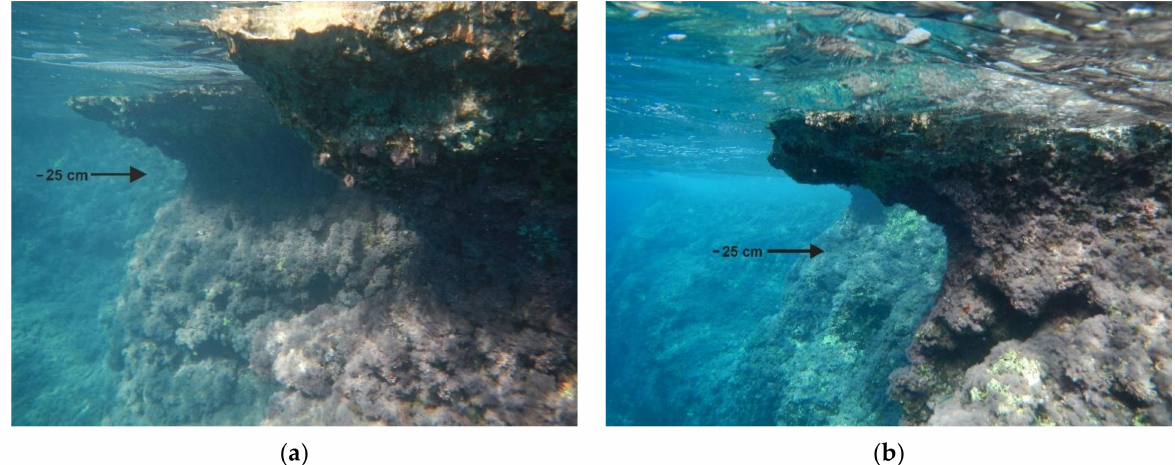
Figure 4. ( a ) Submerged tidal notch at Skopelos Island at about − 25 cm. ( b ) Submerged tidal notch at Alonnisos Island at about − 25 cm.